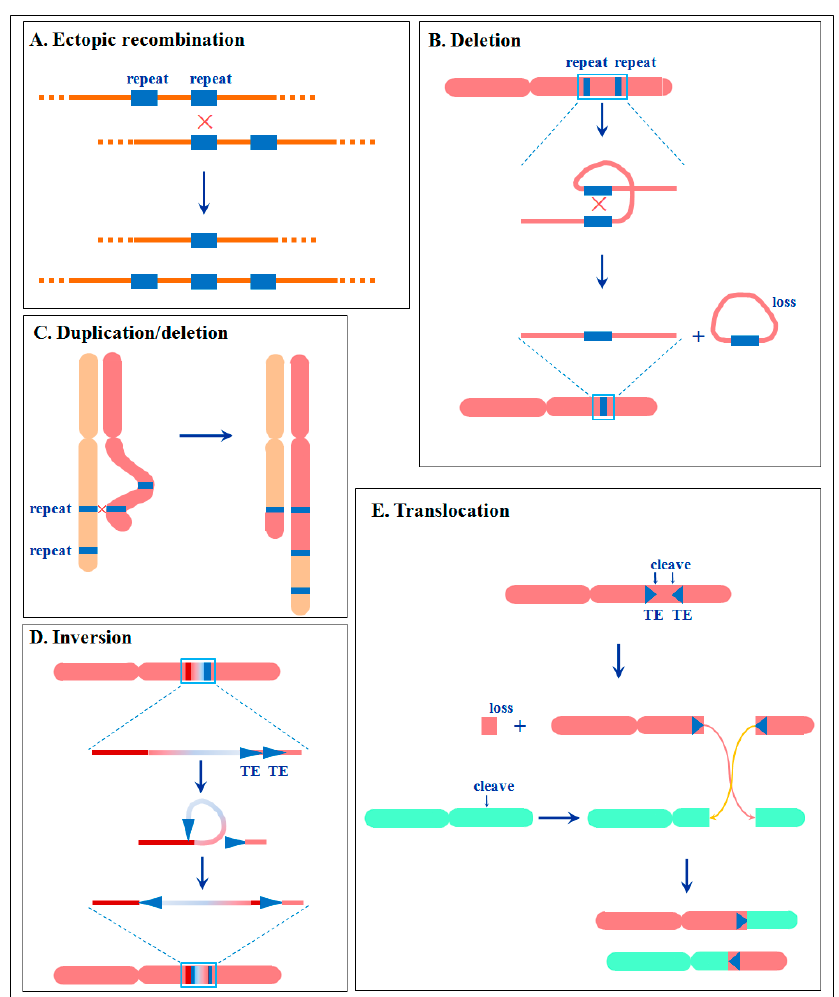
Figure 3. A simple scheme summarizing the effect of repetitive sequences involved in individual processes on chromosome structure. See details in text. processes on chromosome structure. See details in